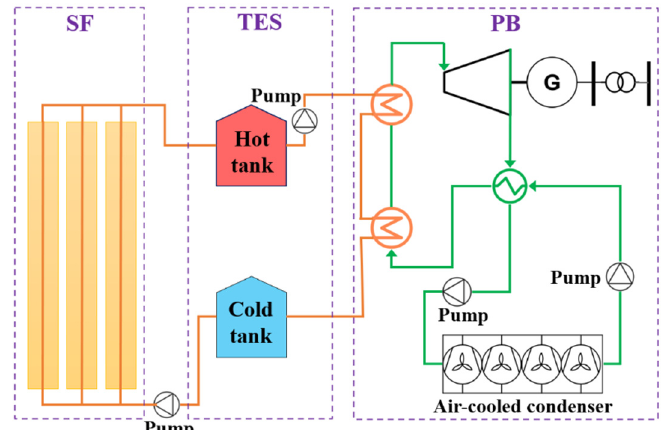
Figure 2. Configuration of the considered CSP plant.